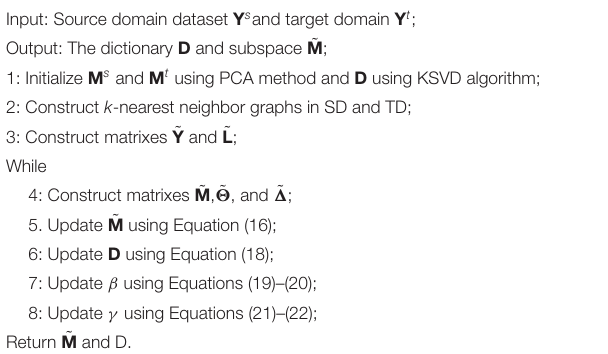
Algorithm 1 | DASRC: domain adaptation sparse representation classifier.